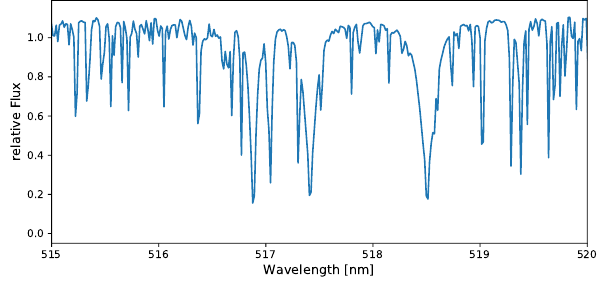
Fig. 20.— Narrow region from a solar spectrum. Data from the IAG Solar Flux Atlas, Reiners et al. 2016 When working with raw data from spectra, certain re- duction steps need to be taken. Some of those are simi- lar to the reduction of image data: Flatfielding is again needed to compensate for differing sensitivity of the in- strument in different parts of the spectrum. This is more difficult for a spectrum than for an image, since for a true flat field, you would need a perfectly flat spectrum. Instead, any well-known, preferably smooth calibration spectrum can be used to deduce the varying sensitivity.